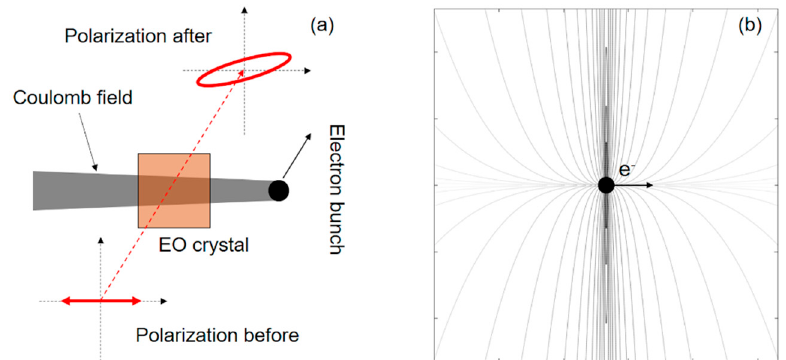
Figure 1. The principle of electro-optic (EO) sampling. ( a ) A probe laser passes through an EO crystal. Due to the external Coulomb field of an electron bunch, the polarization changes from linear to elliptical. ( b ) For a free electron moving at a relativistic speed, the Coulomb field is compressed perpendicular to the electron propagation direction. The arrow in ( b ) indicates the electron propagation direction.